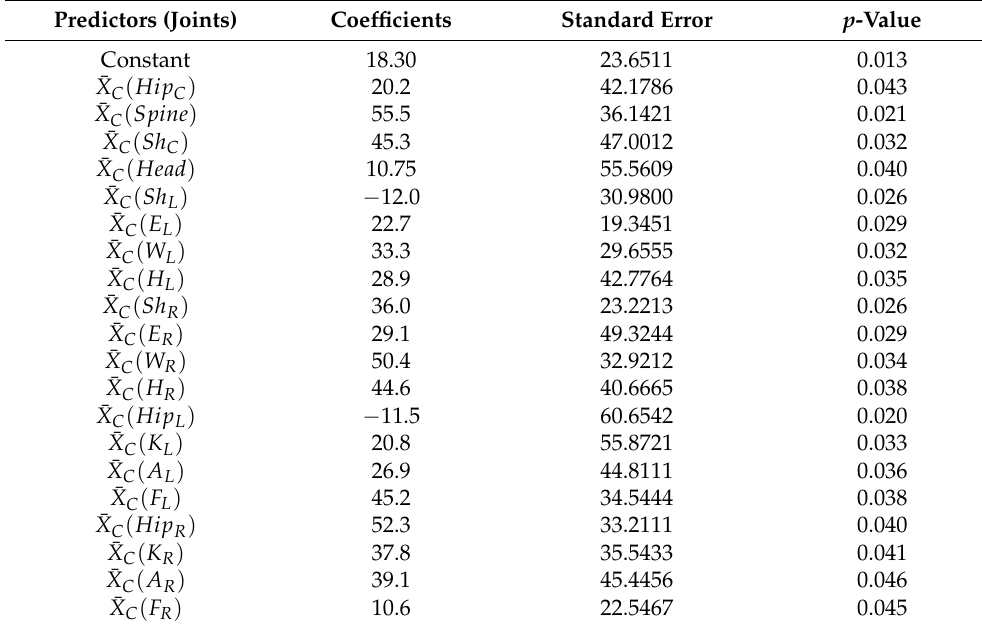
Table 7. Standard error, coefficient, and p -Value of binary logistic regression